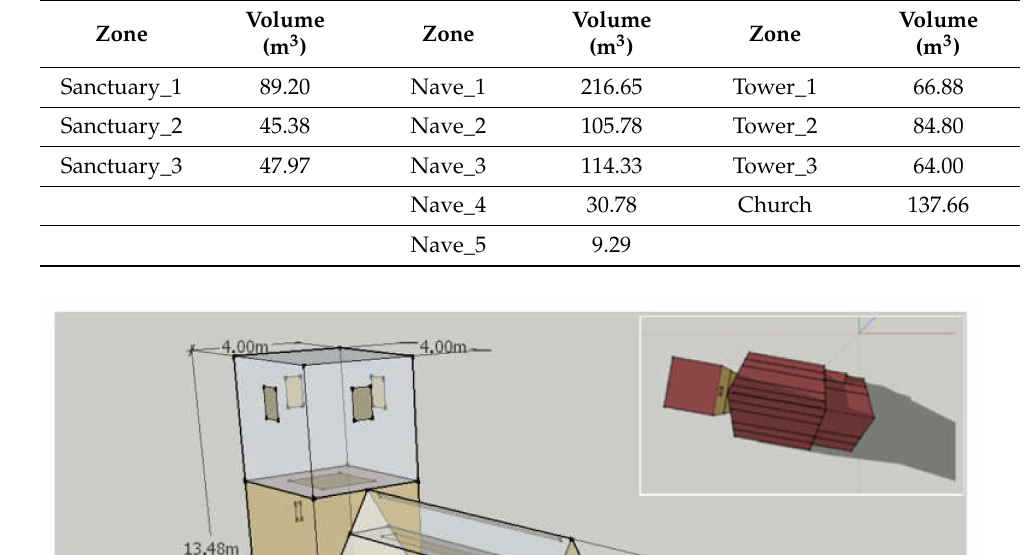
Table 2. BPS zone model characteristics.